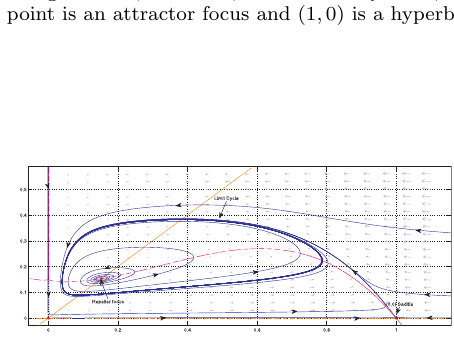
Figure 5. Considering A = 0 . 1 , B = 0 . 02 , S = 0 . 3 and Q = 0 . 7, the unique positive equilibrium point is an attractor focus and (1 , 0) is a hyperbolic saddle.